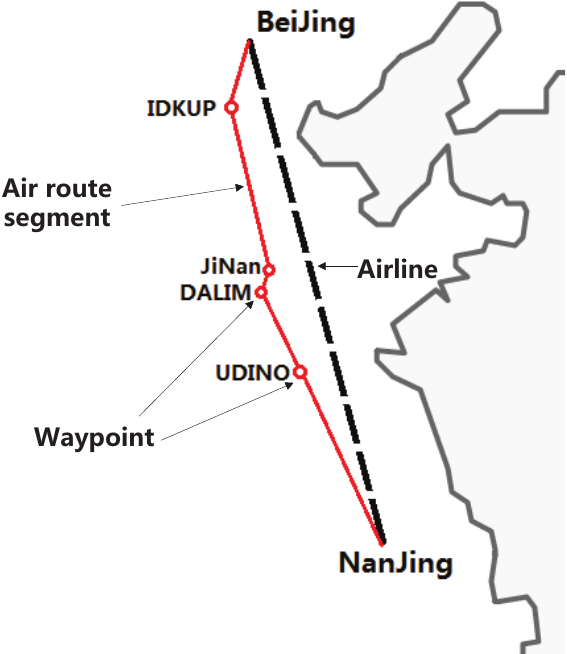
Figure 1. An example of air route and city-pair airline from Beijing to Nanjing.